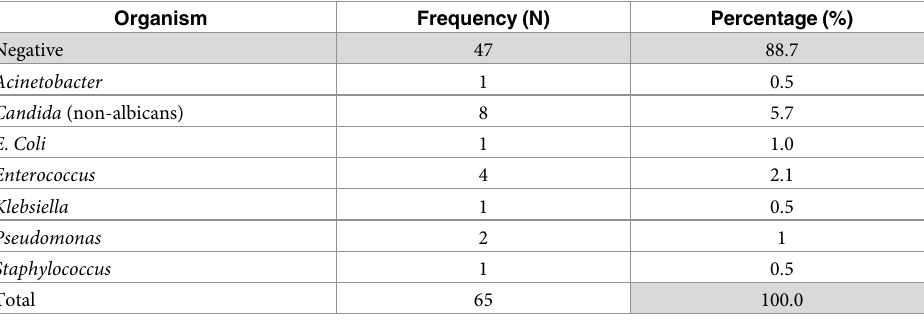
Table 2. Results of the culture of the urine of patients with COVID-19 and